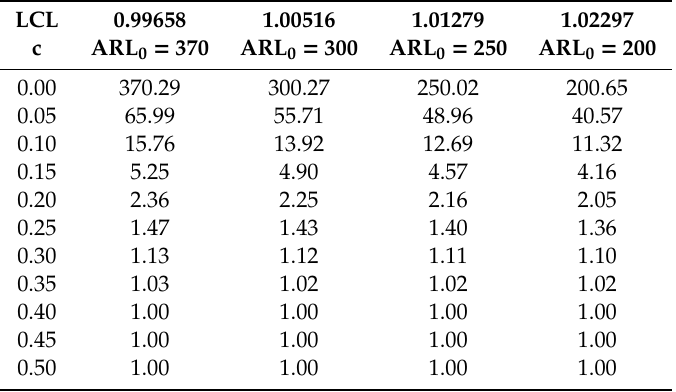
Table 10. The ARLs for the proposed chart when n = 50, GD (3.0,0.75), USL = 6.9553, and LSL = 0.2534.